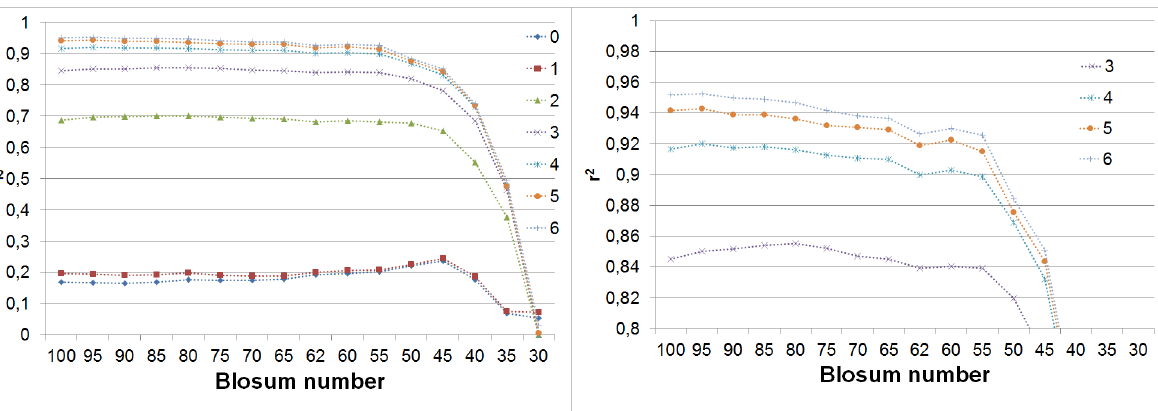
Figure 2. Squares of correlation coefficients between the of-diagonal elements of B x matrices and their reconstructions. The i-th model of each matrix is reconstructed using i eigenvectors. The reconstruction with i=0 is limited to G-matrix, the remaining models use eigenvectors EVi (i=1…6). The left panel displays entire range of r 2 , the right panel is a close-up for r 2 larger than 0.8.